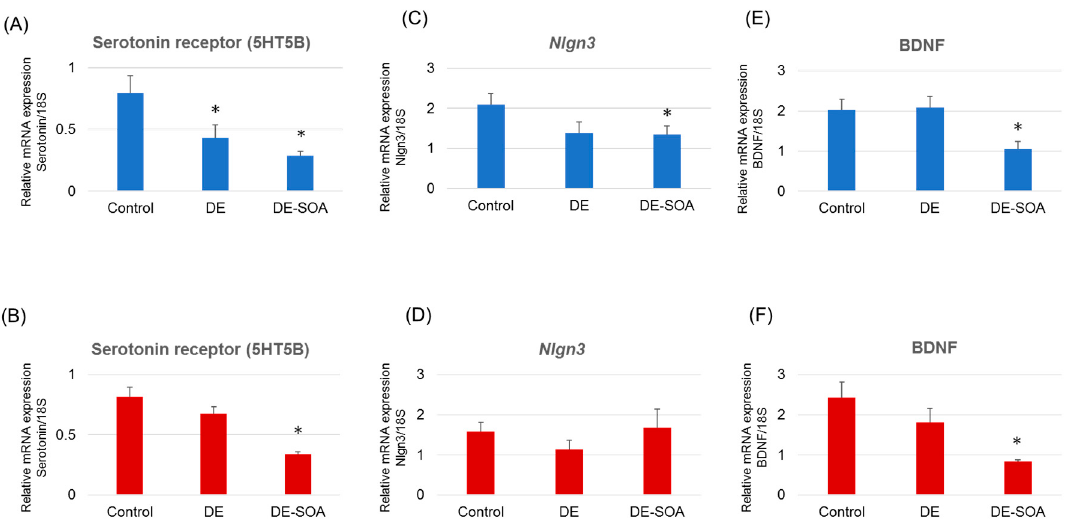
Figure 4. mRNA expression levels of neurological biomarkers. ( A , B ) Serotonin receptor 5HT5B, ( C , D ) Nlgn3 , and ( E , F ) brain-derived neurotrophic factor (BDNF) in the prefrontal cortex of the control and the DE- and DE-SOA-exposed male and female rats. ( n = 14, control; * p < 0.05 vs. control).